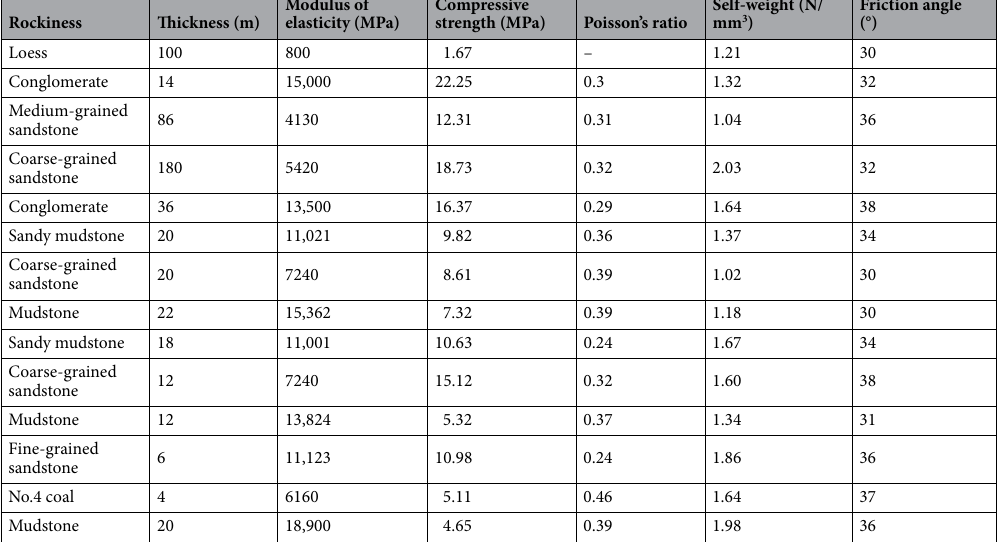
Table 1. Mechanical parameters of coal measures